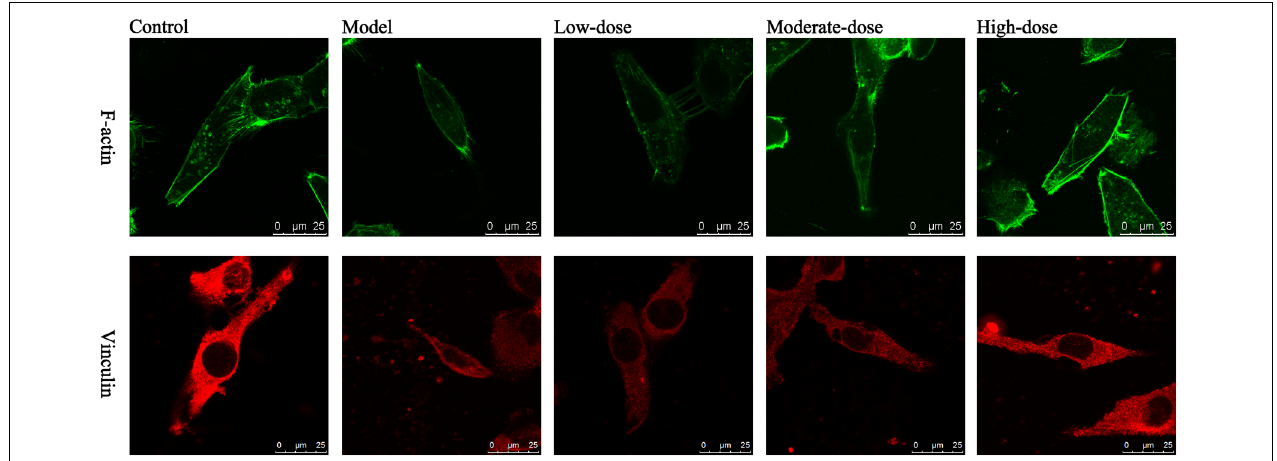
FIGURE 7 | Laser confocal images of F-actin and vinculin in various groups of SAN cells. Green: F-actin; red: vinculin; scale bar: 25 µ